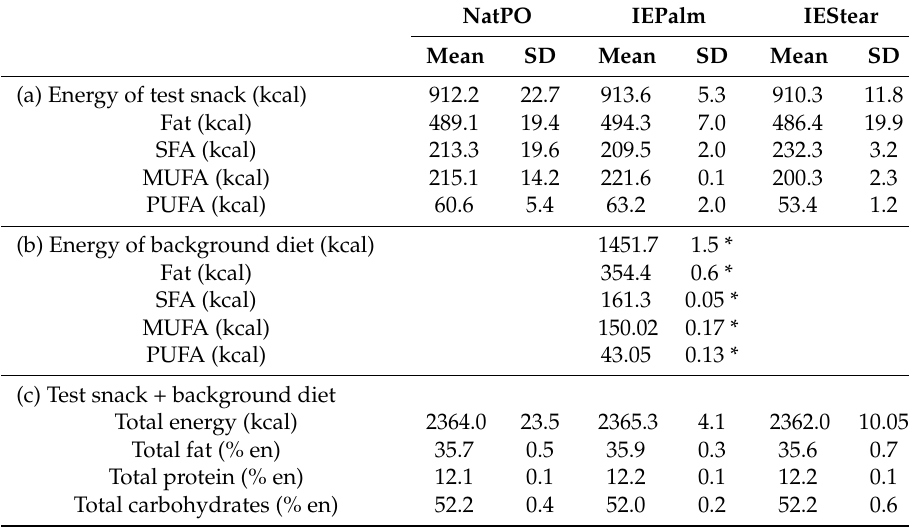
Table 2. Daily dietary intake of subjects in 8 weeks